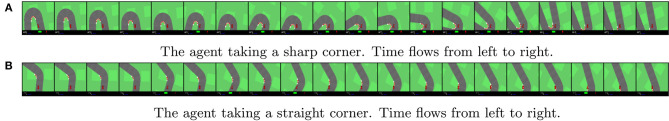
Active inference agent performance in corners. The agent will sometimes cut shallow corners (B) in order to achieve its goals as fast as possible. When the corner is too sharp to safely cut (A) the agent will follow the road instead.